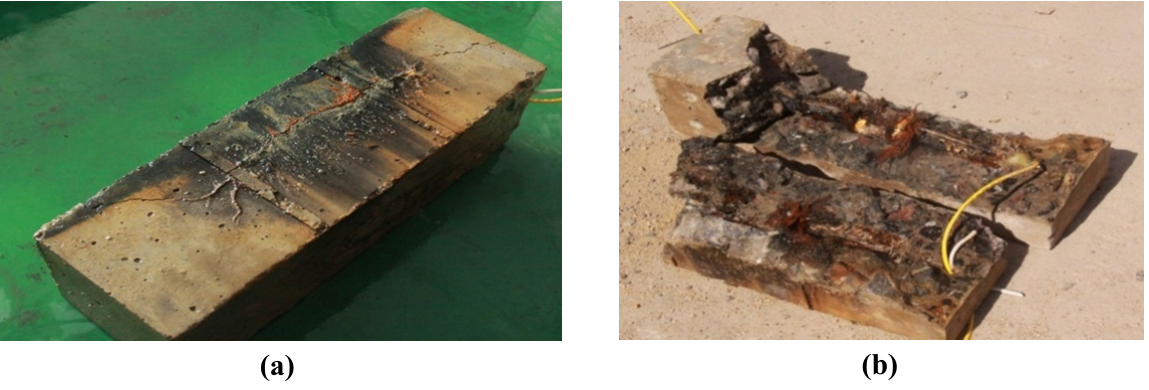
Figure 24. (a) The large cracks of the specimen No.4; (b) Corrosion of the steel rebar in specimen